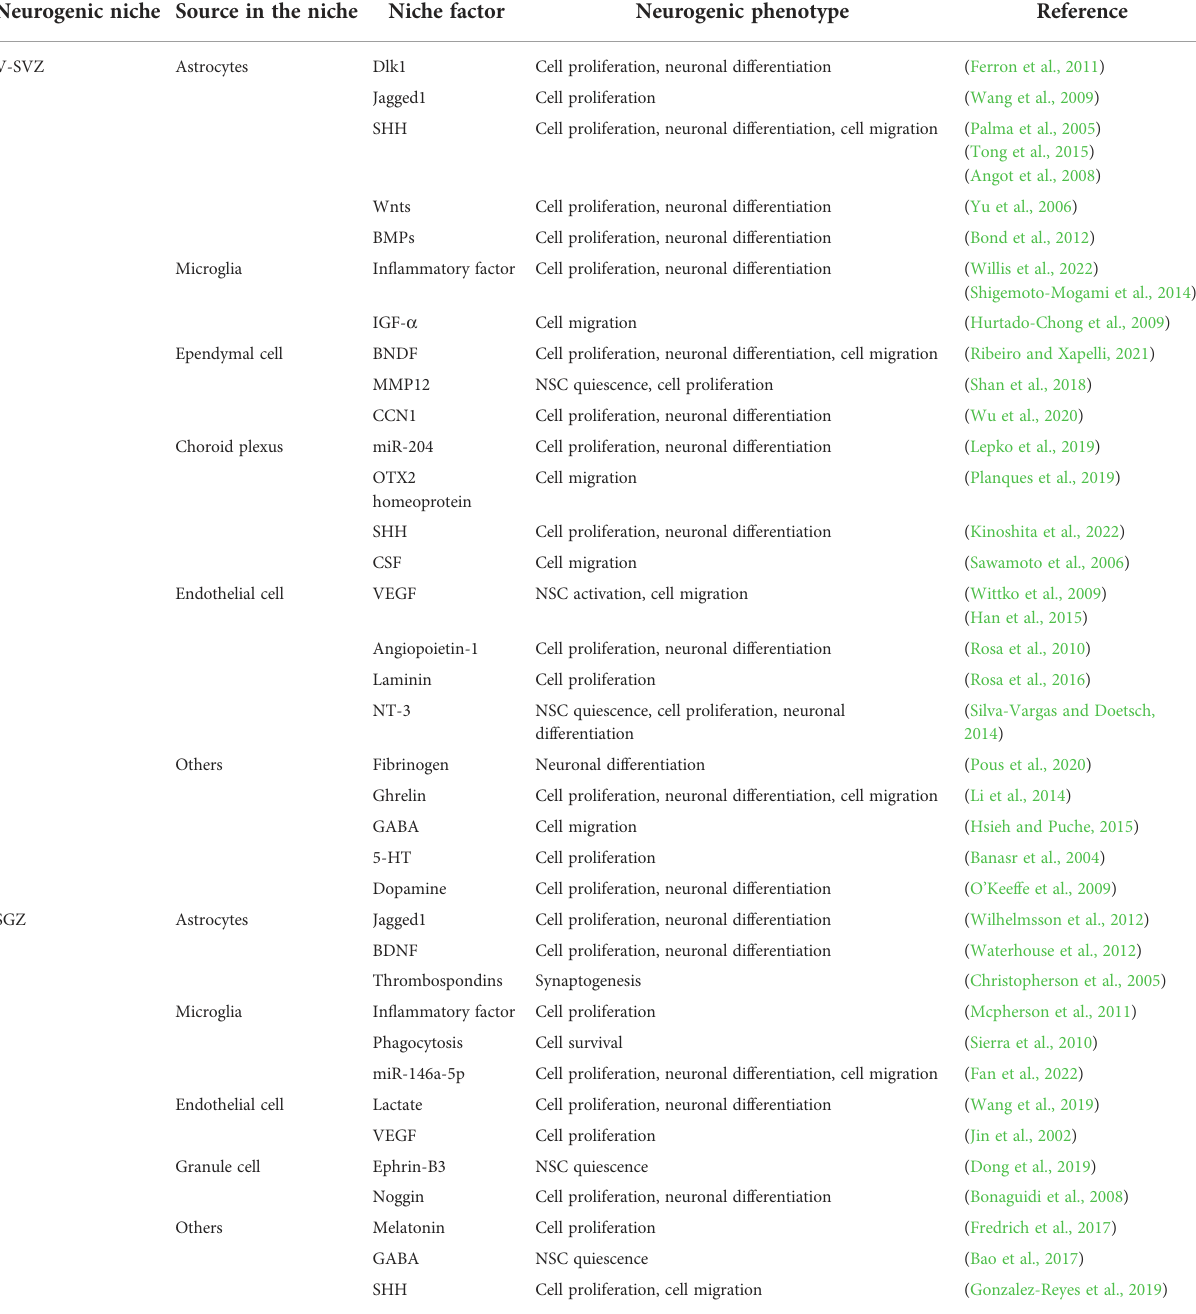
TABLE 1 The Alternations and In fl uences of Niche Factors in Different Regions on Neurogenesis. Neurogenic niche Source in the